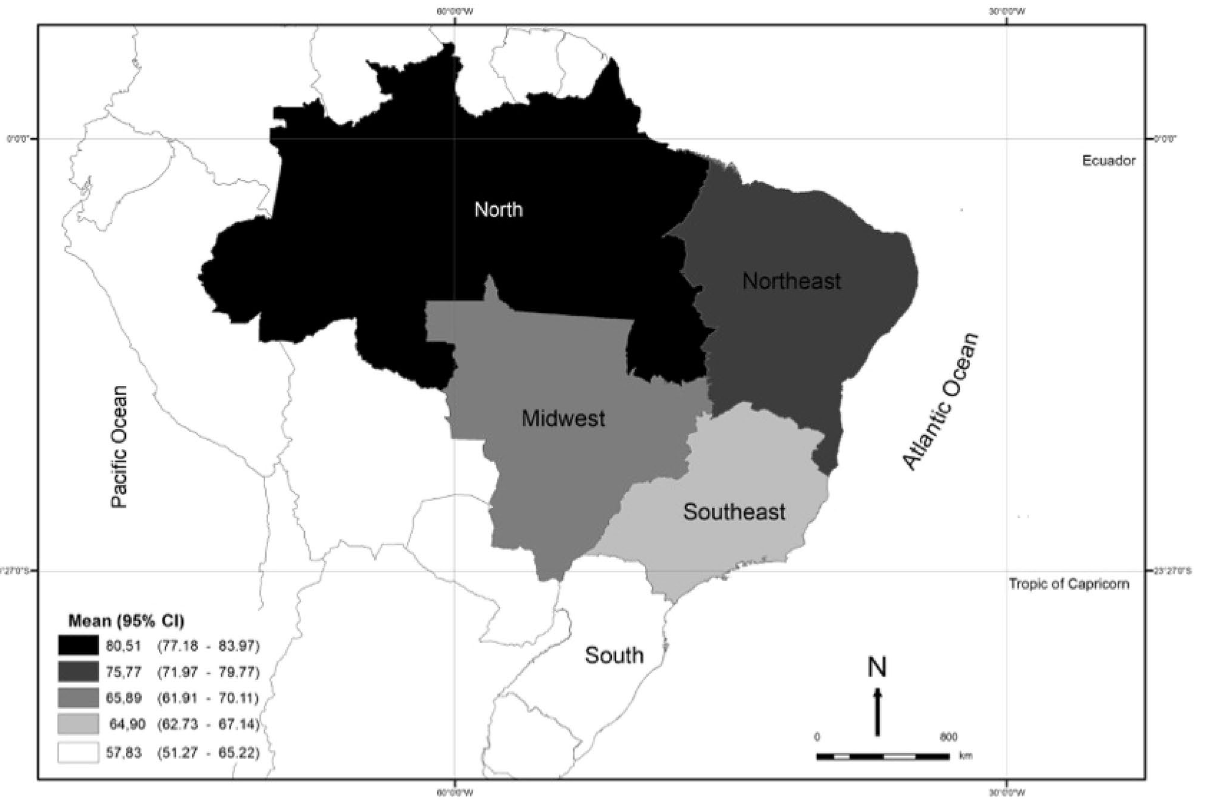
Figure 1. Map of Brazil showing mean 25OHD serum concentrations by geographical region. The Brazilian Longitudinal Study of Aging (ELSI), 2015–16. The map was generated by using the GIS (Geographic Information System) software ArcGIS, Version 10.4, Environmental Research Institute (ESRI Inc.) (https ://www. esri.com/en-us/arcgi s/about -arcgi s/overv